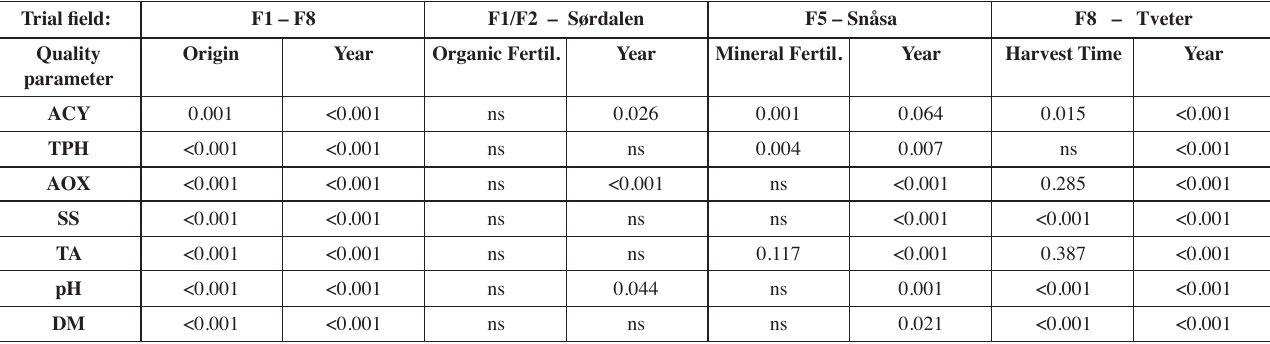
Tab. 3: ANOVA analysis (Fisher’s test; 95% individual confidence interval) of effects of geographic origin, organic and mineral fertilization, harvest time (within-season variation) and year-to-year variation on berry quality parameters. Statistical calculations are based on corresponding measurements from years 2008 to